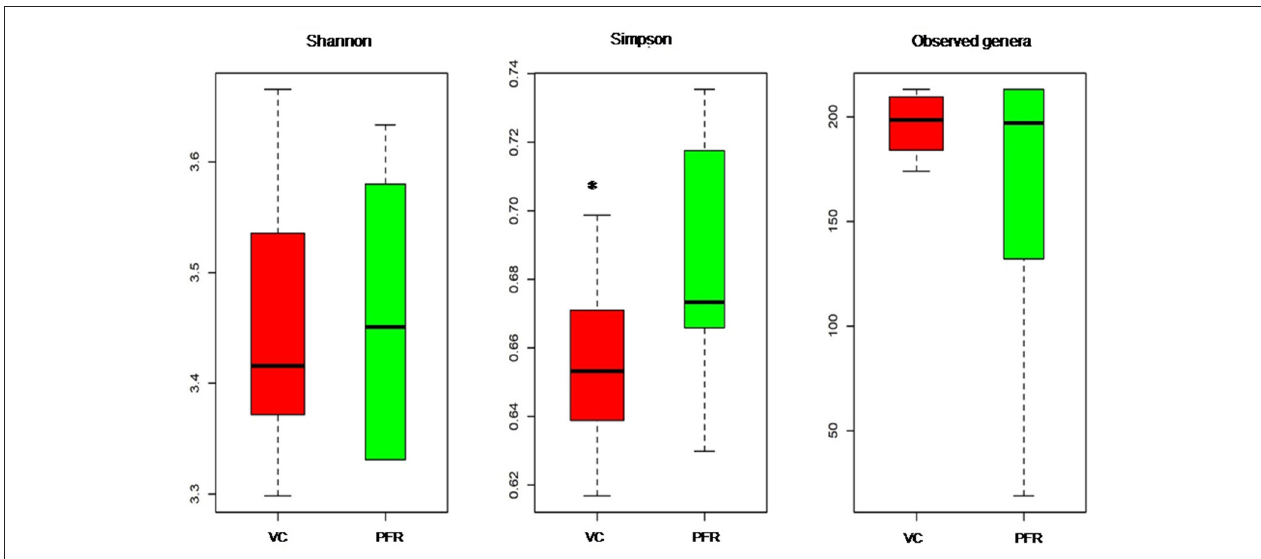
FIGURE 1 | Box-plots depicting the Alpha diversity indices of the viromes in the vitreous fluid of controls (VC) and post-fever retinitis (PFR) groups.*Indicates a significant difference between VC and PFR ( p <